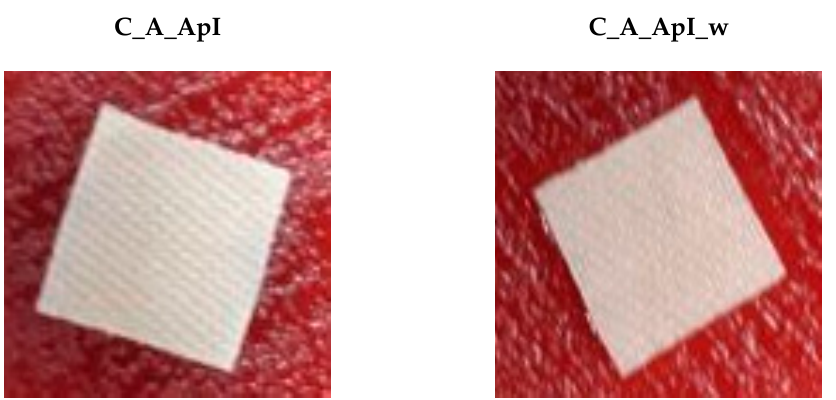
Figure 12. Photographs of antimicrobial testing on Candida albicans samples of cotton fabric in satin weave treated in Bath I before (C_A_ApI) and after the care cycle (C_A_ApI_w).